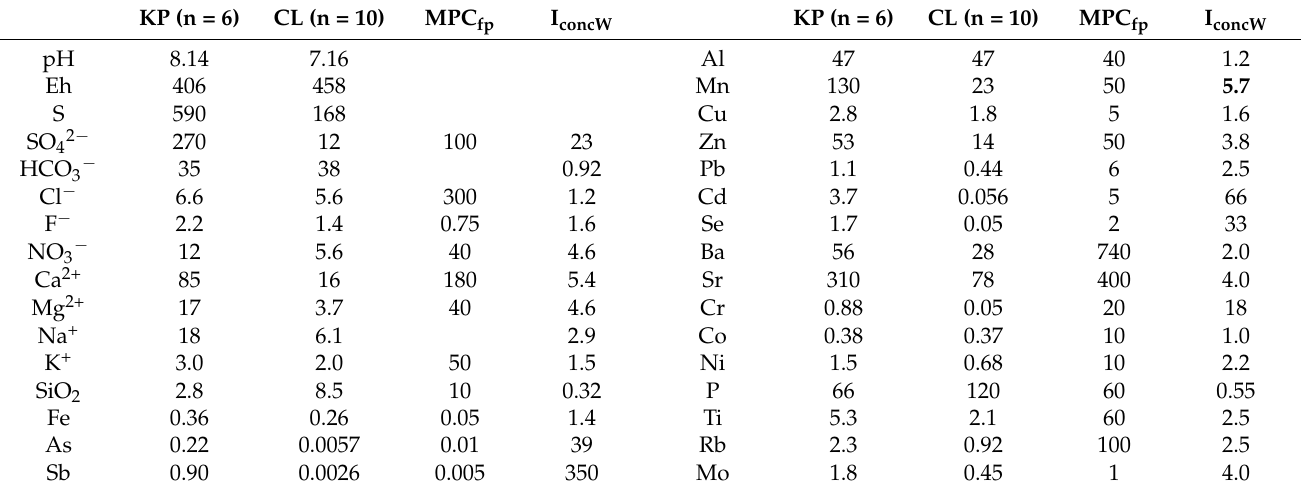
Table 1. Composition of water in Komsomolsk pond and Chany Lake, Eh in mV,